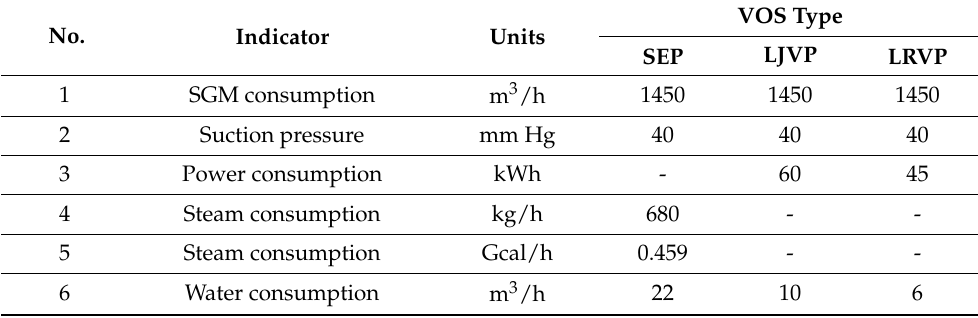
Table 17. Comparison of technological and design parameters of the installation in mode 2.